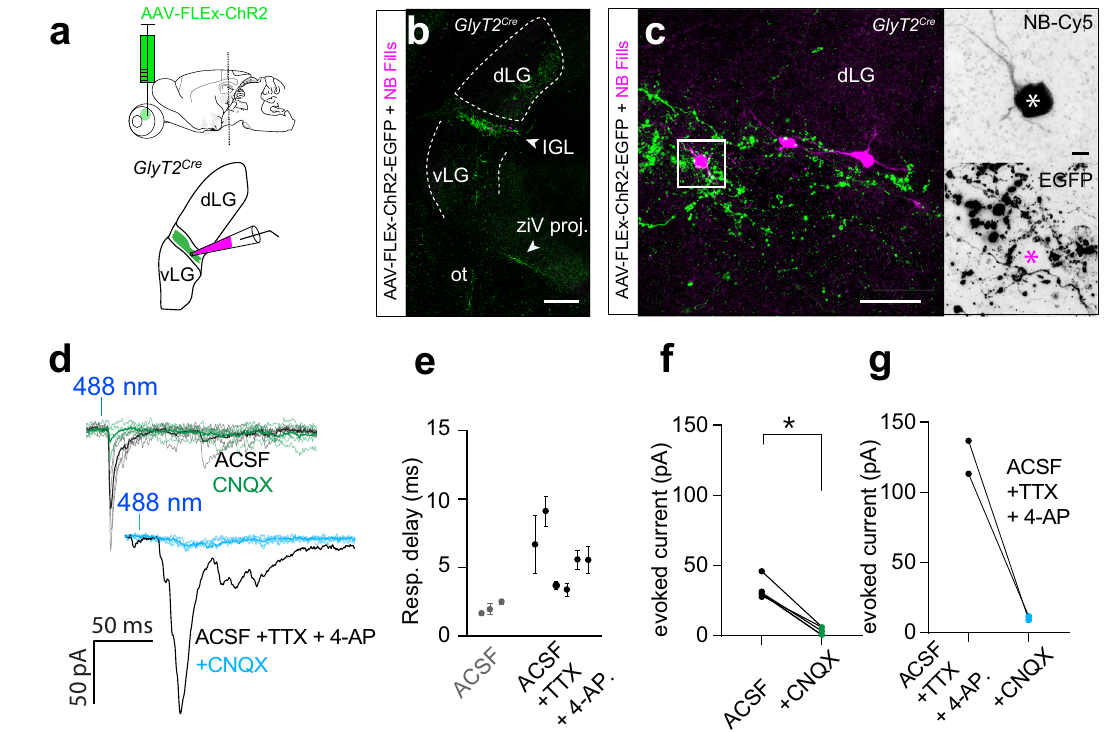
Fig. 9 | SON-ipRGCs release glutamate in the IGL. a Illustration of brain slice recordings in the IGL of the GlyT2 Cre mouse 2 – 3 weeks following Cre-dependent ChR2 expression in the eye. b , c Confocal images of EGFP-expression in the IGL brain slice, fi xed after recording. Biocytin- fi lled IGL neurons surrounded by SON- ipRGC terminals. d Photo-stimulation-evoked inward PSCs blocked by the excita- tory antagonist CNQX. Photo-stimulation evoked inward PSCs in tetrodotoxin and 4-aminopyridine (4-AP) were blocked with CNQX. e Response delay indicating the time to peak following a 1ms ChR2 stimulation in ACSF ( n =3 cells data were